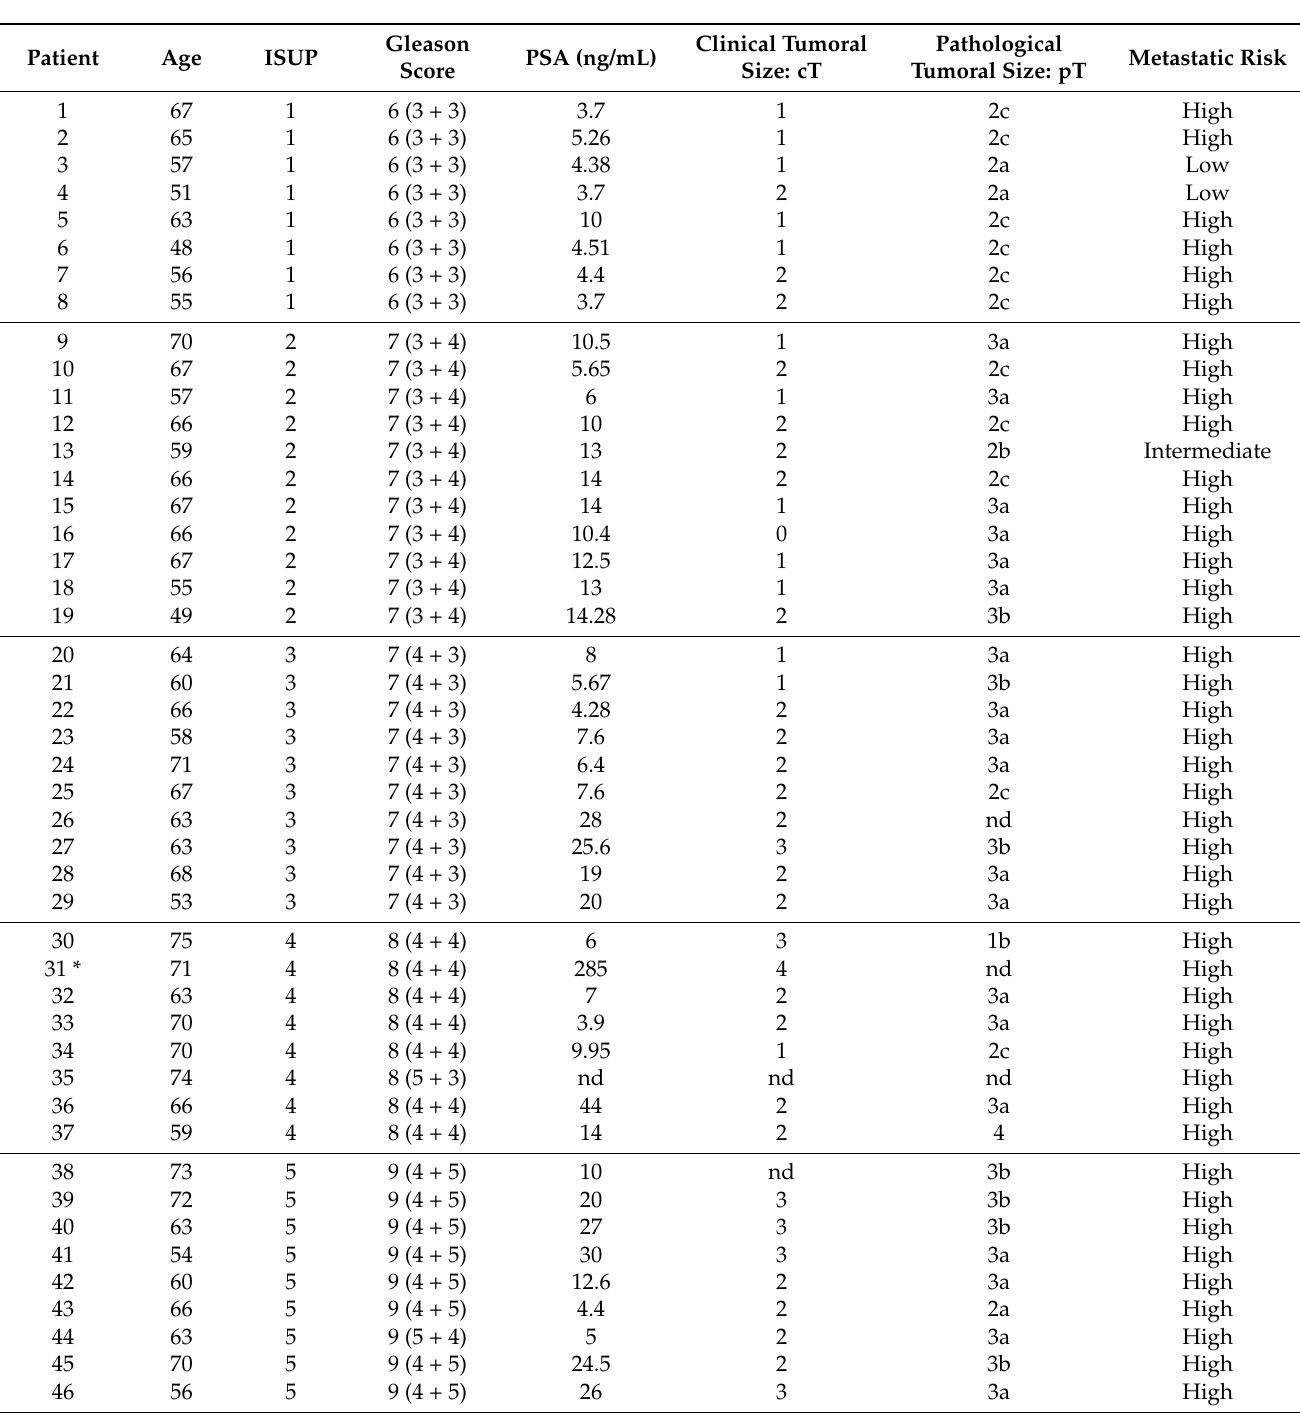
Table 2. Characteristics of the patients from which samples have used in this study. ND not determined. PSA prostate specific antigen. * All patients were NxMX or N0M0 except for patient no. 31, who was stage